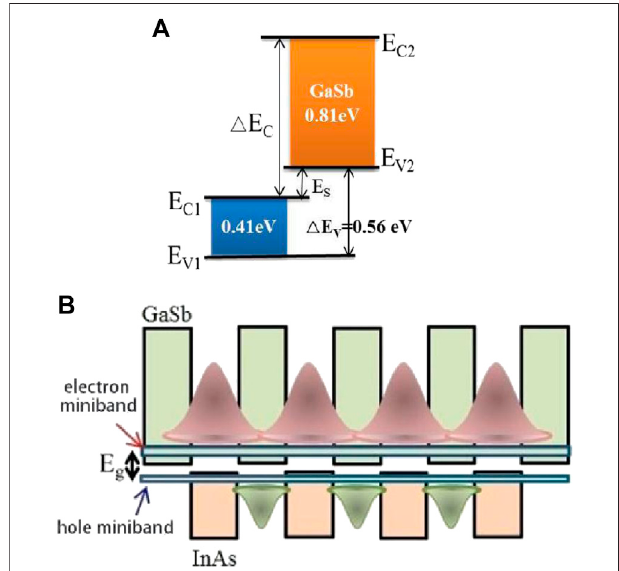
FIGURE 1 | (A) Band structure alignment of InAs/GaSb at 0 ° K. In the InAs/GaSb superlattice, the conduction band of InAs is about 0.15 eV lower than the valence band of GaSb, and its heterojunction forms an off-type energy band. (B) InAs/GaSb superlattice energy band structure is a staggeredtypeIIbandstructure,causingelectronsandholestobecon fi nedin the InAs layer and GaSb layer,